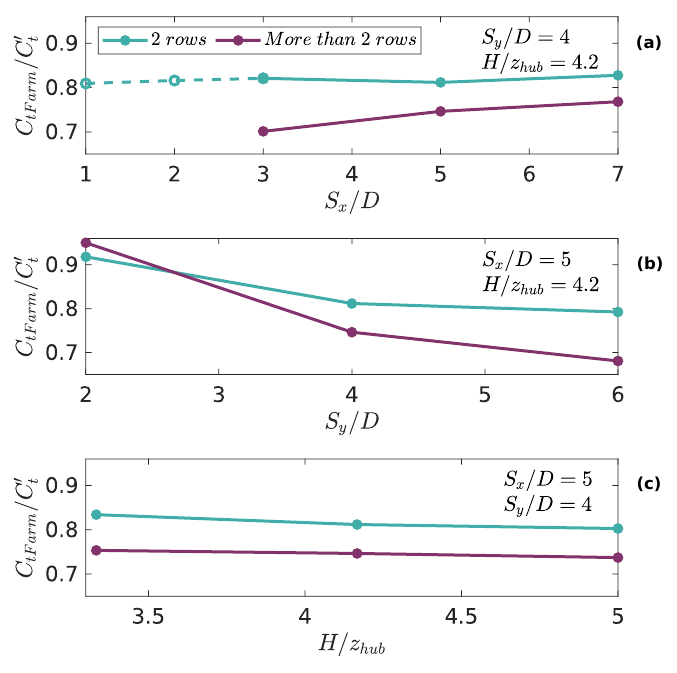
Figure 8. Changes in C tFarm due to the variation of: ( a ) the streamwise distance between devices, S x / D ; ( b ) the spanwise distance between devices, S y / D ; and ( c ) the ratio between the depth of the channel and the hub height, H / Z hub . The results are divided into two cases: farms with two rows of turbines (light blue), and farms with more than two rows (purple). Since we do not observe a significant influence of S x / D on C tFarm for farms with two rows, we perform extra simulations (marked with dashed lines), where we see C tFarm remains insensitive to the distance in the streamwise